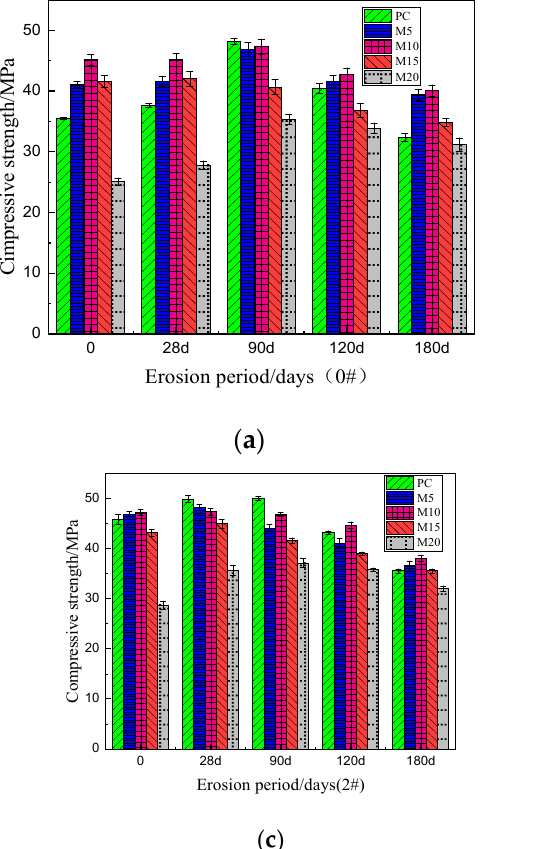
( b ) Figure 5. Compressive strength of PC and M10 after a different erosion period under various curing methods; ( a ) PC, ( b ) M10.